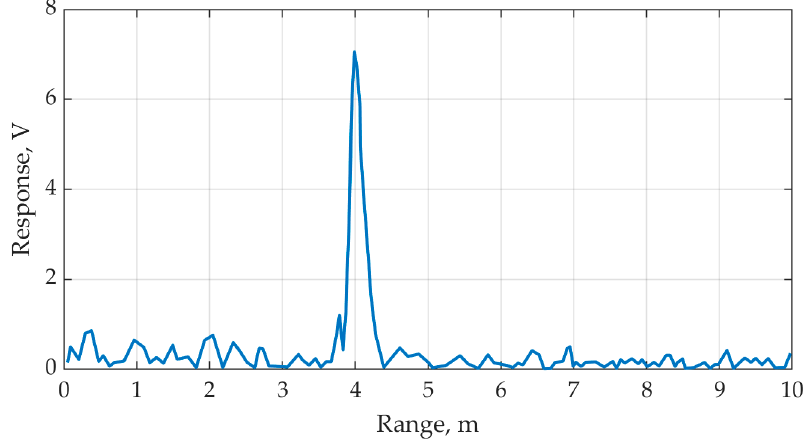
Figure 4. Range profile in one frame after applying the interperiod subtraction algorithm for the signal shown in Figure 3b.